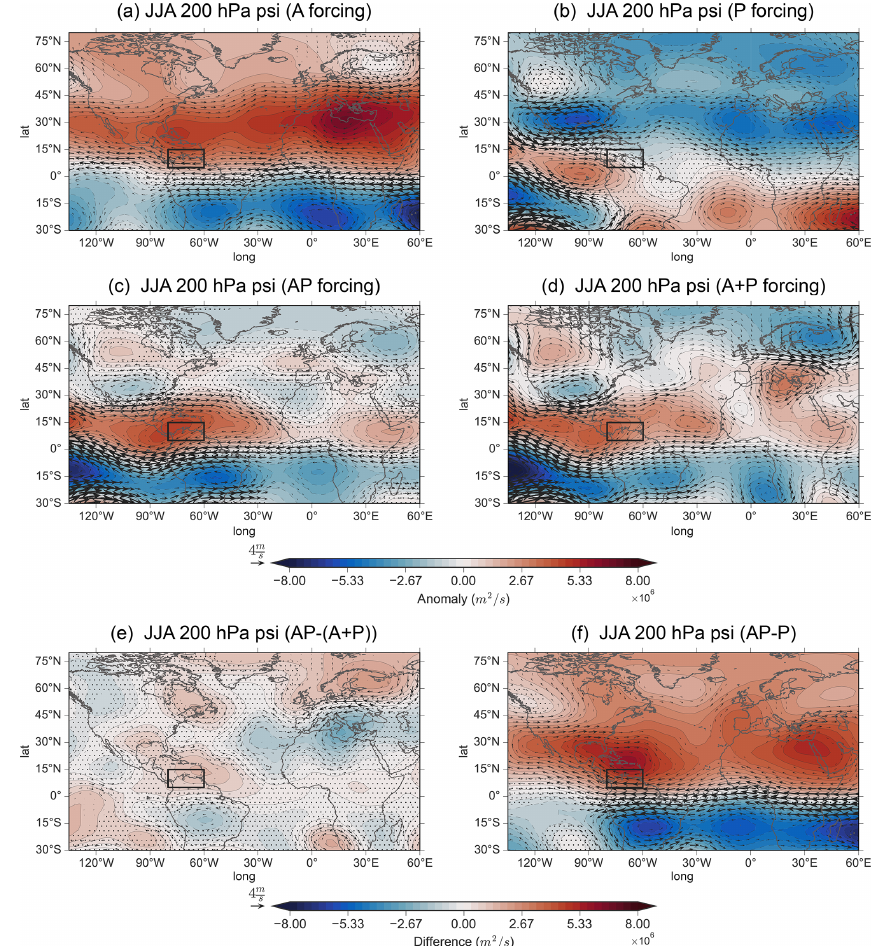
Figure 7. Same as Fig. 6 but for